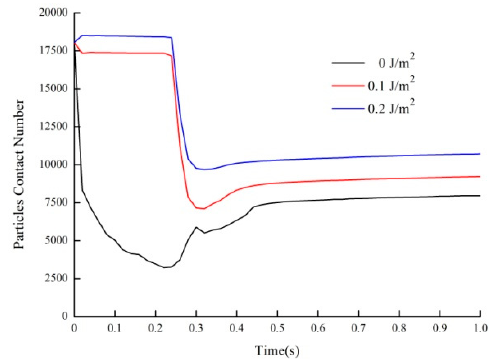
Figure 18. The total particles contact number of wet soil granular flow.